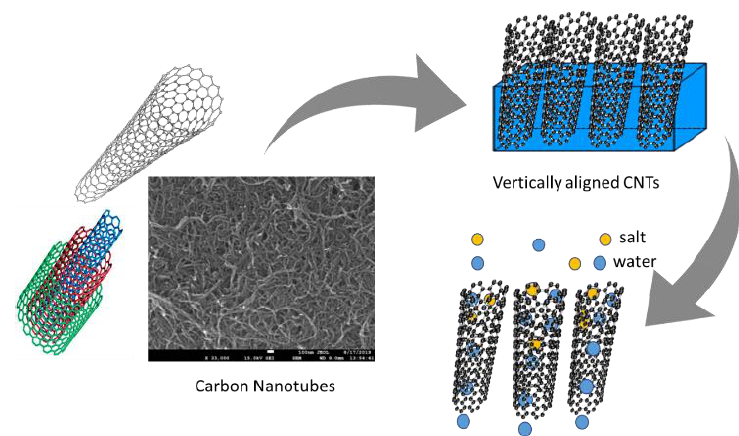
Figure 7. Schematic of CNT membrane fabrication [25].